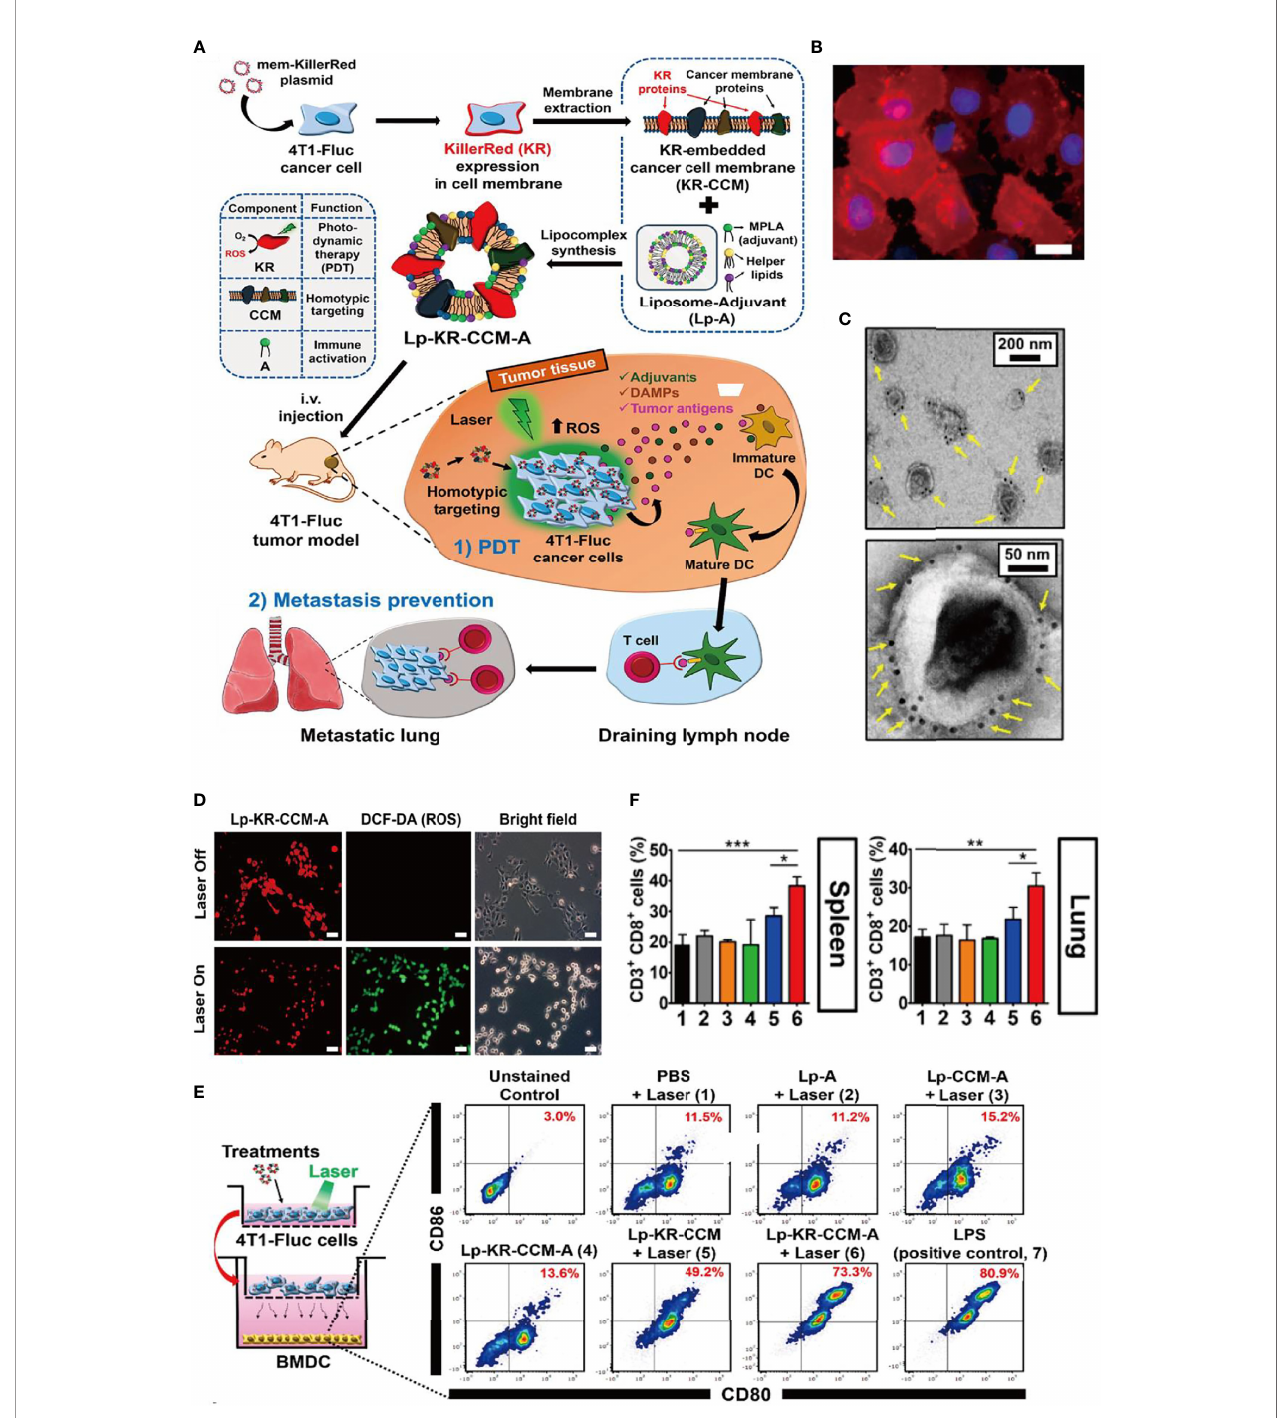
FIGURE 1 | Bioinspired membrane-based nanotherapeutics for photo-immunotherapy. (A) Schematic illustration of preparation of Lp-KR-CCM-A and its application in cancer therapy. KR as photosensitizer in Lp-KR-CCM-A and can produce ROS upon laser irradiation to kill cancer cells (PDT) and thus enhance immunotherapy with the help of lipid adjuvant MPLA. (B) Representative FL image showing KR expression in 4T1-Fluc cell membrane after transfection with mem-KR plasmid. (C) Lp-KR-CCM-A stained with KR antibody-conjugated immuno-gold. (D) In vitro ROS generation induced by Lp-KR-CCM-A internalized in 4T1-Fluc cells upon laser irradiation for 20 min. DCF-DA was used as an indicator of intracellular ROS. (E) In vitro BMDC maturation following different treatments and irradiation of 4T1-Fluc cells in a co-culture system. (F) Analysis of cytotoxic CD8 + T cells (gated on CD3 + T cells) in the spleen and lung after the indicated treatments. *p < 0.05; **p < 0.01; ***p < 0.001. Reproduced with permission (27), Copyright 2019, American Chemical